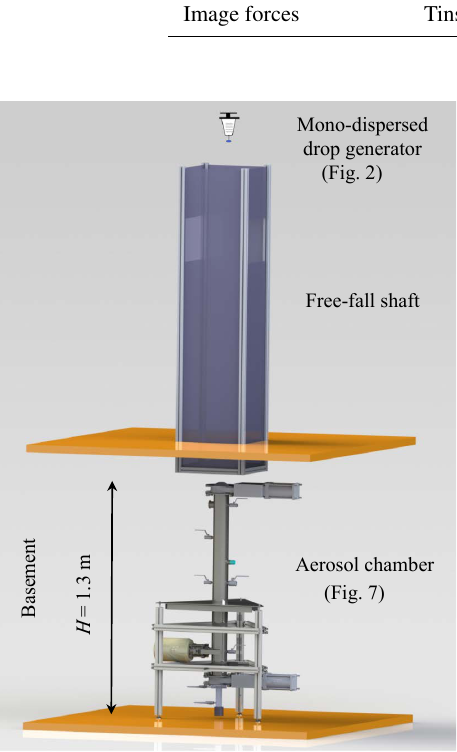
Figure 1. The new BERGAME